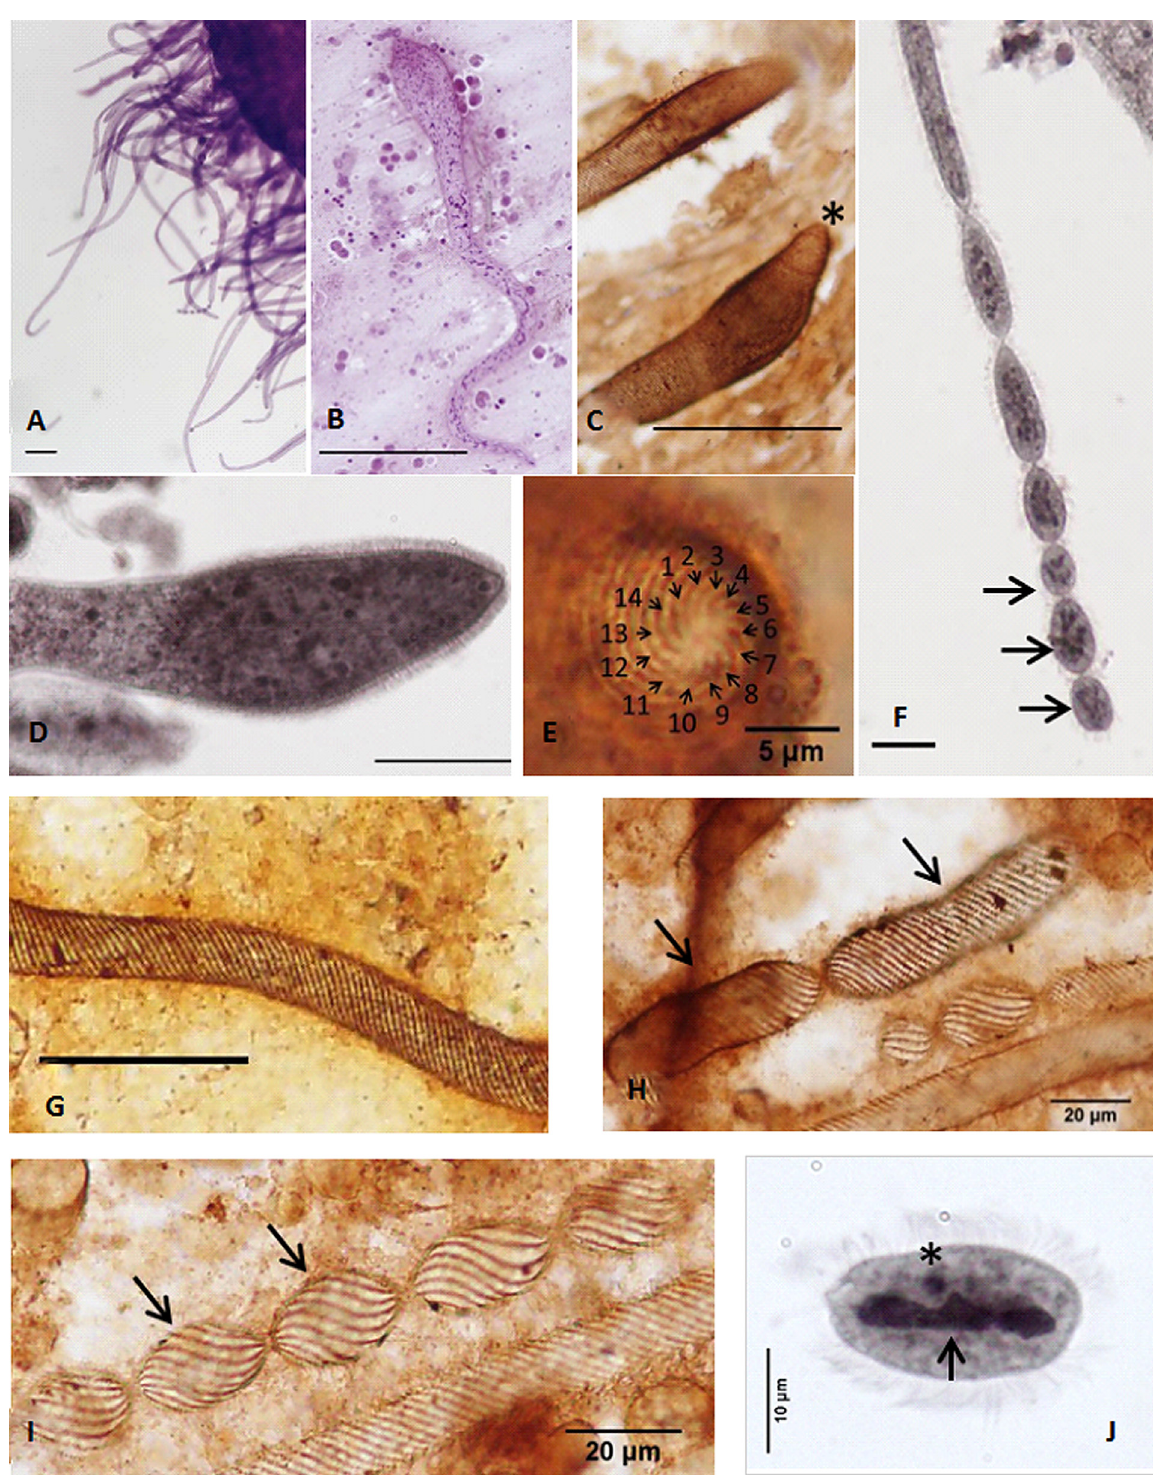
Figure 1. Chromidina elegans (Foettinger, 1881) Gonder, 1905: morphology. (A) General view of infected renal sac. Parasites are attached to the renal tissues by their anterior end with their cell body hanging free in the renal coelom. (B) Tropho-tomont. (C, D) Club-like and inflated anterior ends of tropho-tomonts (*: apical papillum). (E) Apical ciliature consisting of 14 kineties that extend continuously through the entire cell body. (F) Palintomy (arrow: protomites with condensed chromatin). (G) Cell body ciliature. (H) First generation of protomites (arrow: fission plan). (I) Chain of second generation of protomites (arrows). (J) Free tomite (*: micronucleus, arrow: macronucleus). (A, B) Haematoxylin staining. (C, E, G–I) Chatton’s silver impregnation. (D, F, J) Osmium staining. Unless otherwise indicated, bar = 100 l m. (A–J) Neohapantotype and